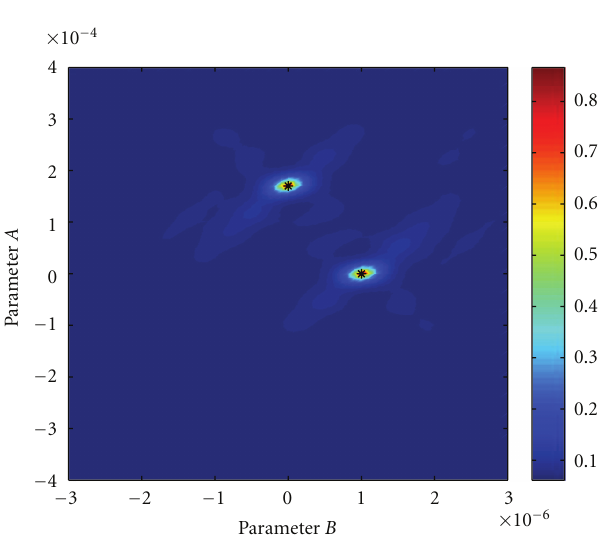
Figure 6: Uncorrelated sources: Determination of parameters A and B based on MUSIC for a di ff ractor and a dipping reflector β = 20 0 . The black stars show the correct parameter locations.